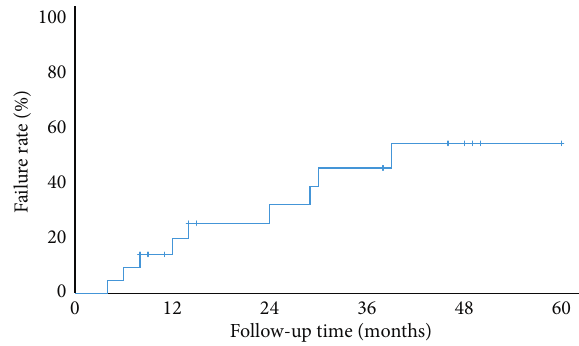
Figure 1: Kaplan–Meier survival curve at six months and one, two, and three years after surgery. Table 2: Success rates of second Ahmed glaucoma valve at postoperative follow-up time points.